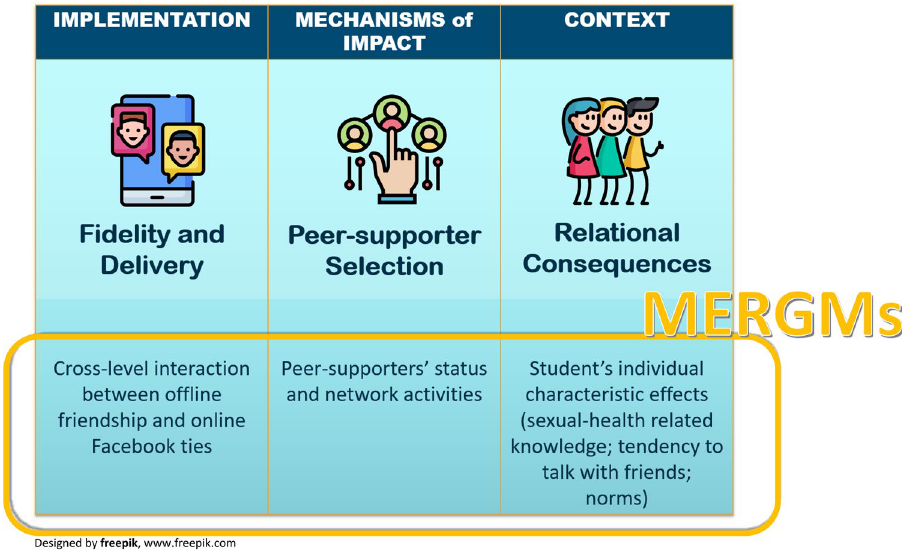
Figure 1. Social Network results and process